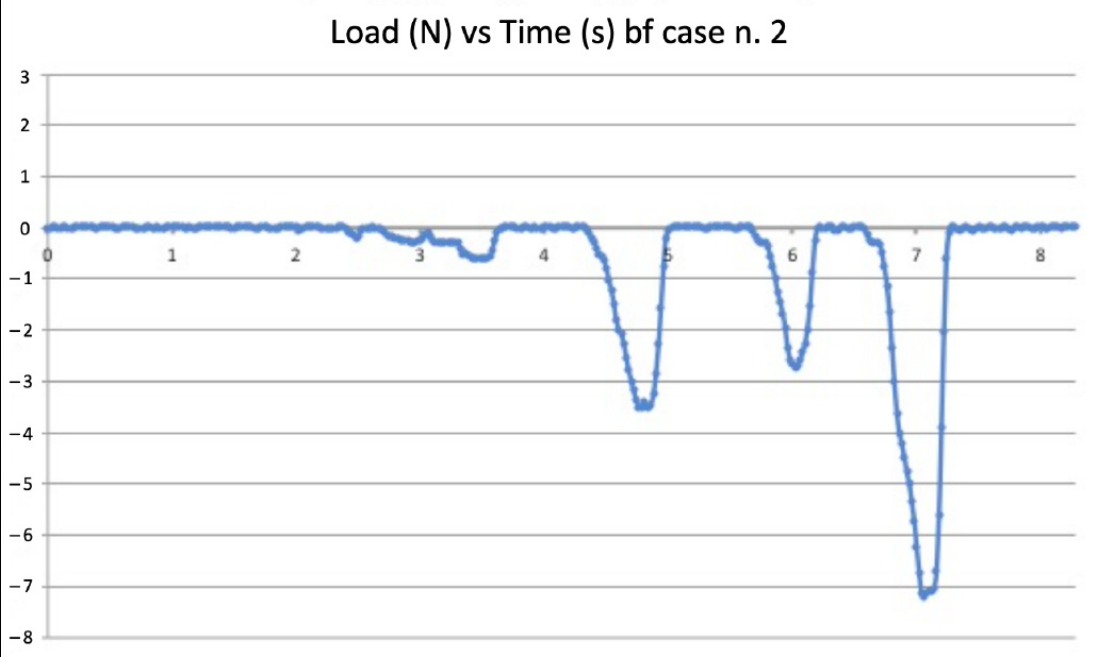
Figure 5. Graphic plot of the simulation on model n. 2 (failed balanced force technique negotiation).